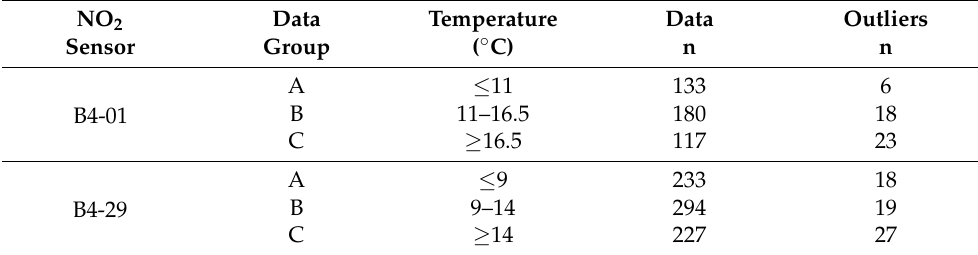
Table 4. Dataset from the training campaign disaggregated by temperature